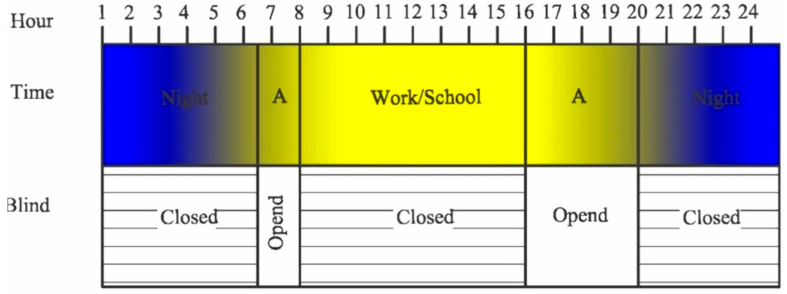
Figure 1. Diagram of the functioning of the external roller shutter during the day; A-Sunlight